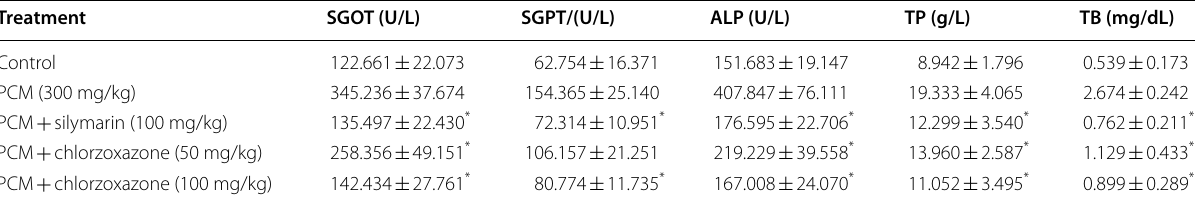
Table 3 Effect of silymarin 100 mg/kg and chlorzoxazone (50 and 100 mg/kg) on the serum biochemical parameters in Paracetamol (300 mg/kg) induced hepatotoxicity and in wistar rats